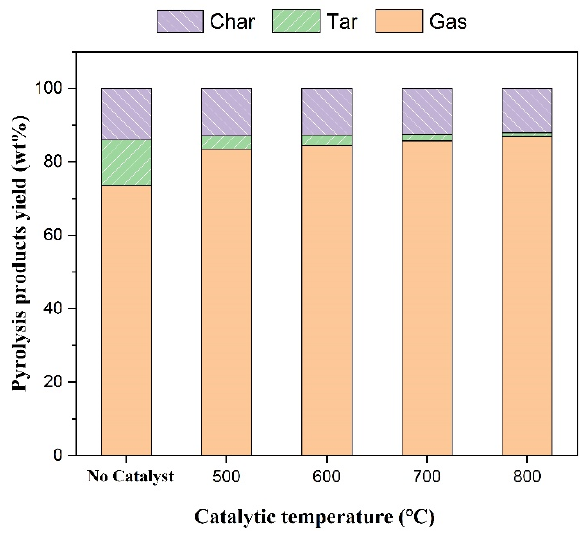
Figure 3. Effect of catalytic temperature on the distribution of pyrolysis products of pine sawdust.